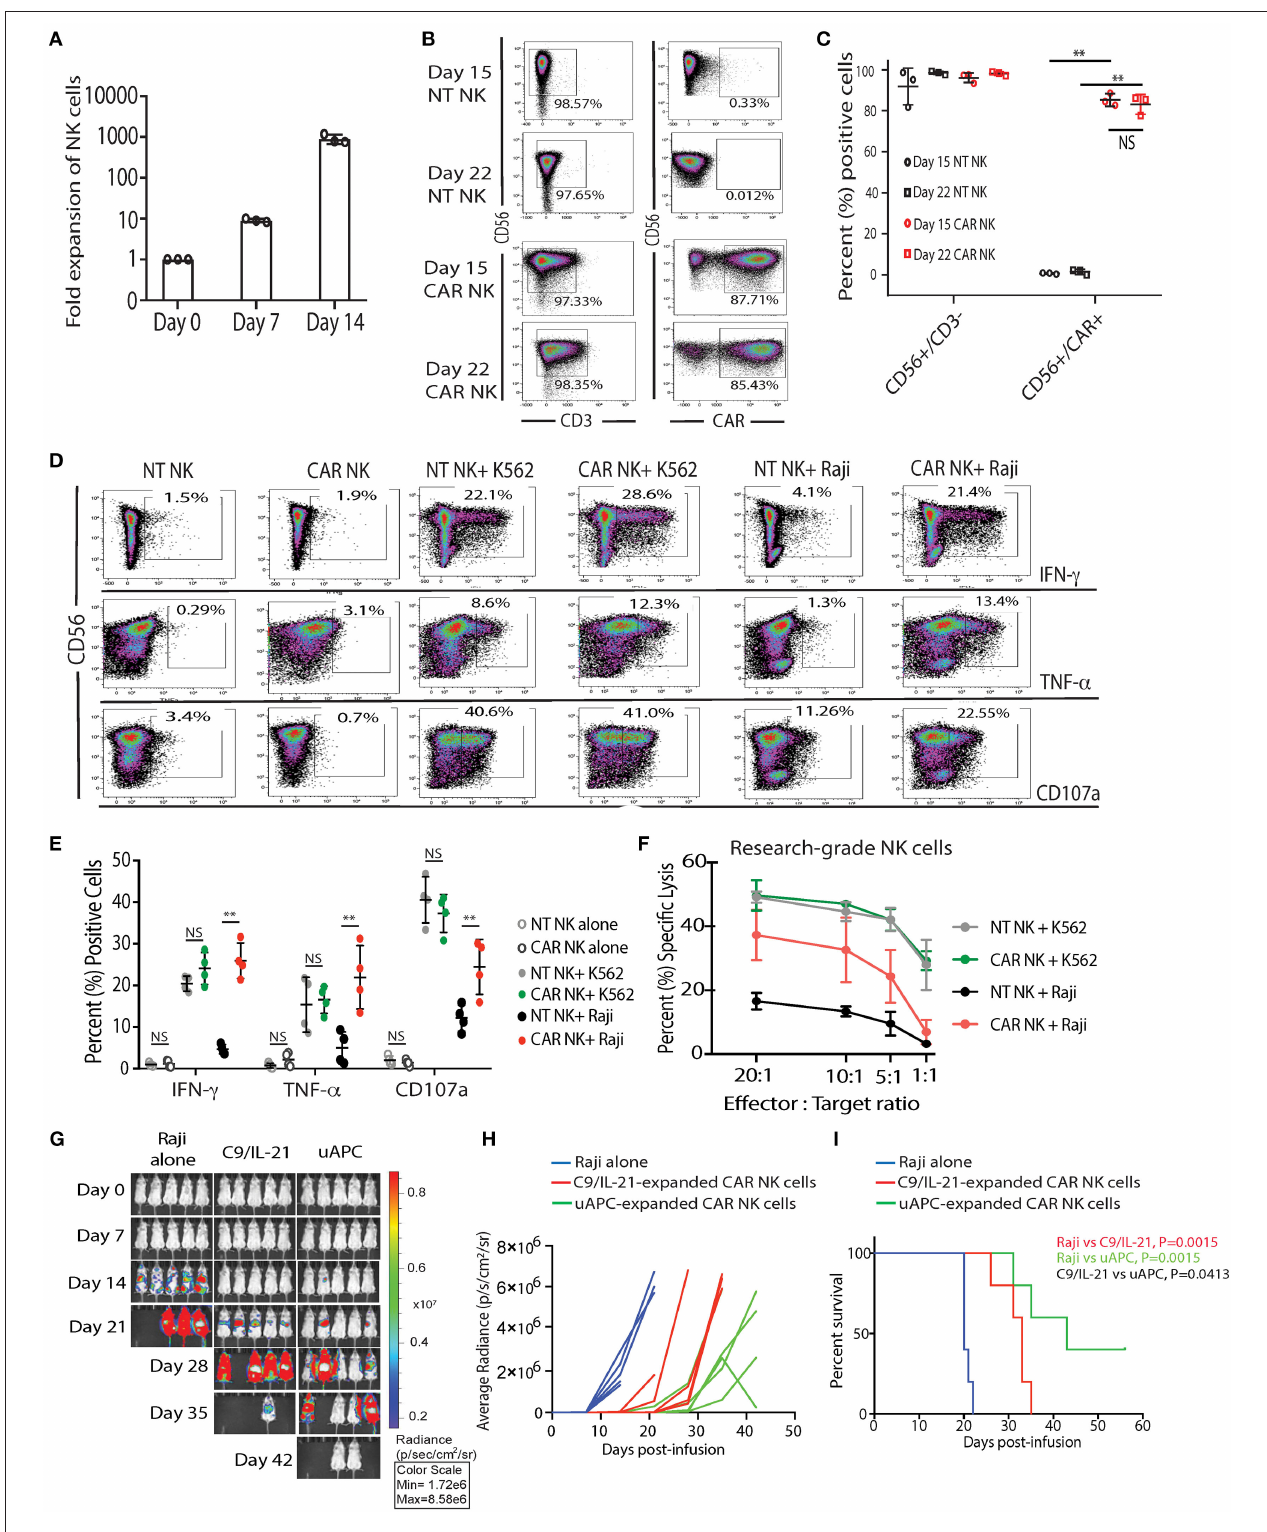
FIGURE 3 | uAPC promotes the proliferation and cytotoxicity of research-grade NT and iC9/CAR19/IL-15 NK cells. (A) Fold expansion of research grade CB NK cells at day 0 (baseline) or after co-culture with uAPC for 7 or 14 days. Bars represent standard error of the mean (SEM) ( n = 3 independent